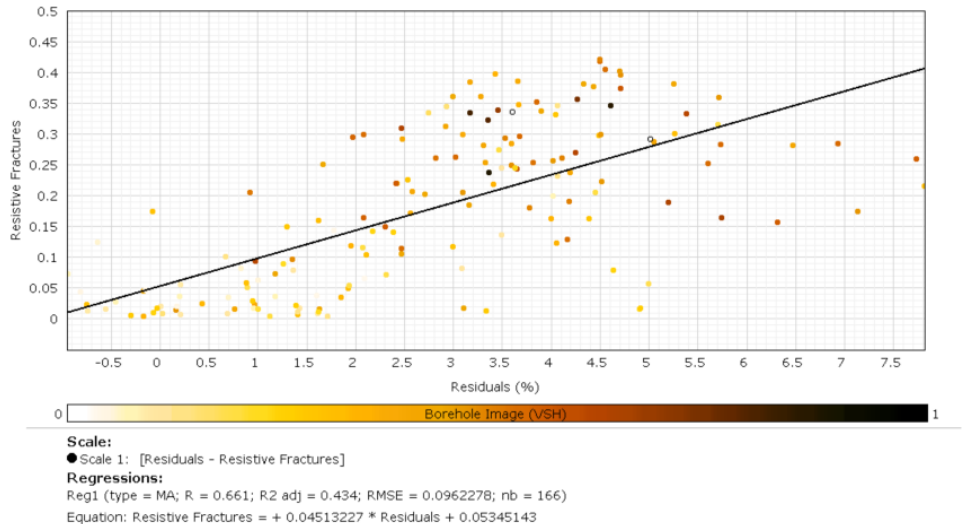
Figure 10. Cross-plot in the first well showing residuals (difference between the dipole acoustic anisotropy and the calculated anisotropy) on the (x-axis) and resistive fracture frequency (y-axis), after resampling at 25 feet. The cross-plot is colored by VSH (shale volume fraction) values, with lower values in the lighter colors (carbonates) and higher values in the darker colors (shales). The sample size of the dataset (nb) = 166. The correlation (R) between the predictor variable VSH and the response variable anisotropy is 0.66.